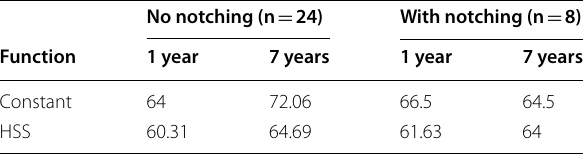
Table 3 We can see how the function (measured according to Constant and HSS) improved at the 7‑year assessment in patients without notching ( p < 0.05)